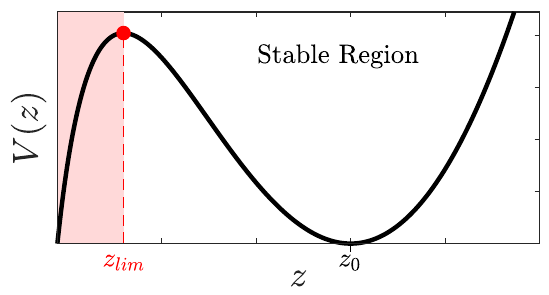
Figure 4. Energy-like Lyapunov function for first order filter